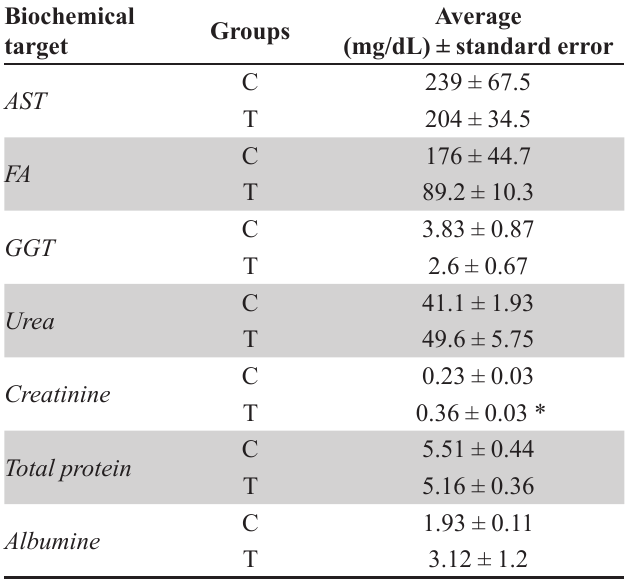
TABLE I - Biochemical results of renal and hepatic acute toxicity of animals treated with 2,000 mg/kg of E. edulis (T) and control (C) pulps